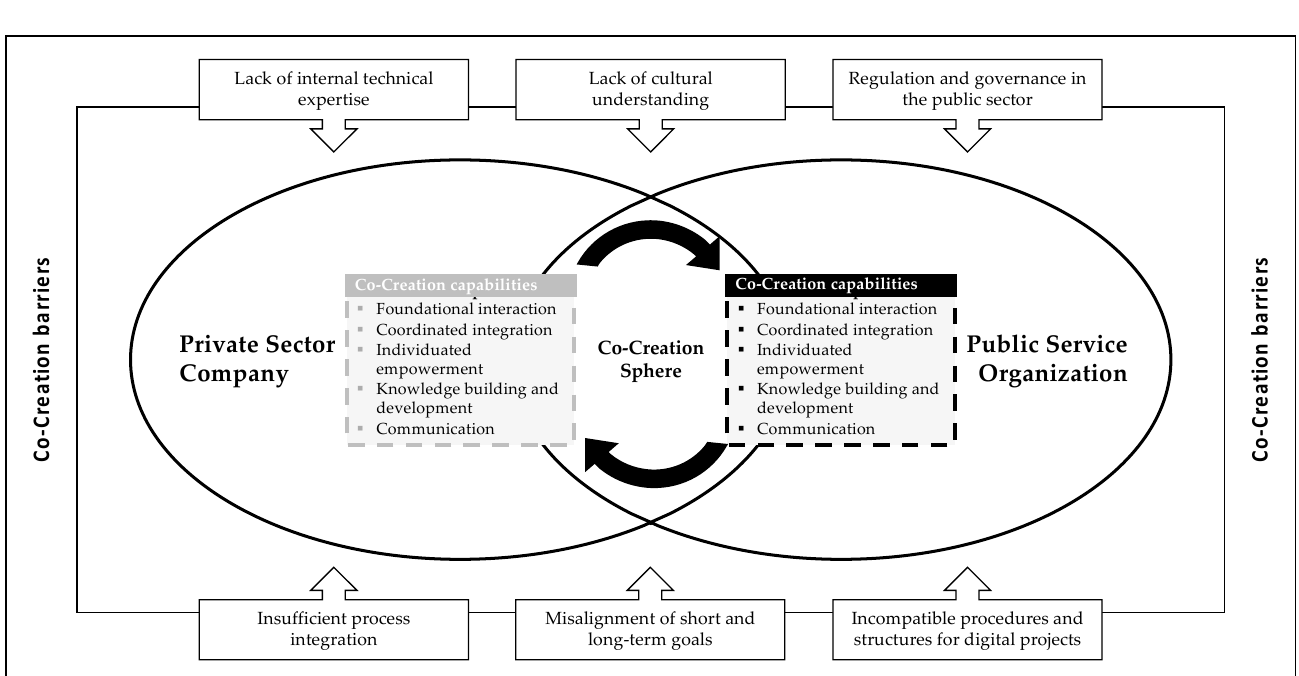
Figure 2. Overview of identified barriers and capabilities for co-creation.